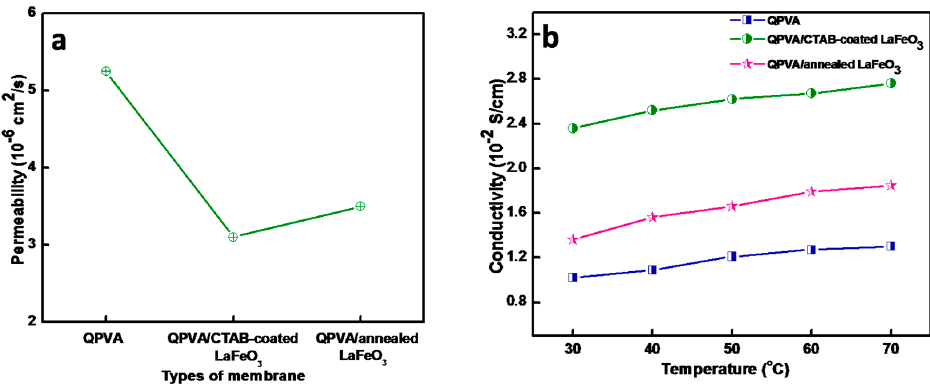
Figure 5. ( a ) Methanol permeabilities of QPVA, QPVA/CTAB-coated LaFeO 3 , and QPVA/annealed LaFeO 3 nanocomposite membrane at 30 °C; and ( b ) ionic conductivities of QPVA, QPVA/CTAB-coated LaFeO 3 , and QPVA/annealed LaFeO 3 nanocomposites operated at 30–70 °C.